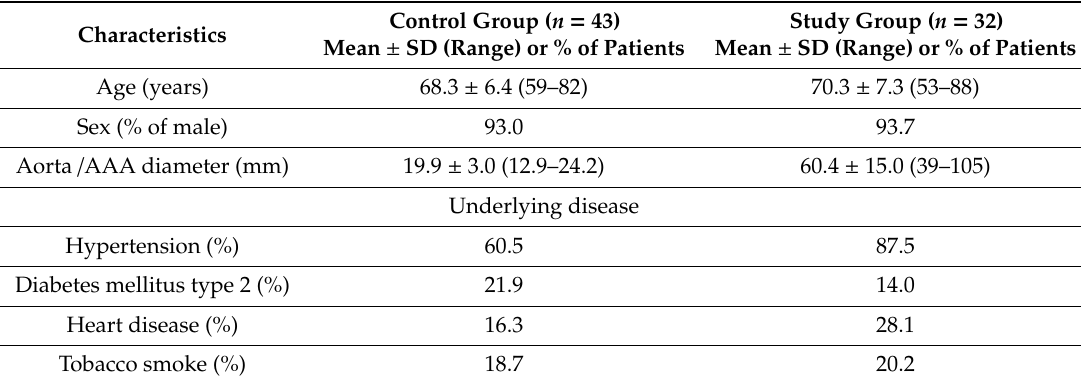
Table 1. Characteristics of the control and study groups.